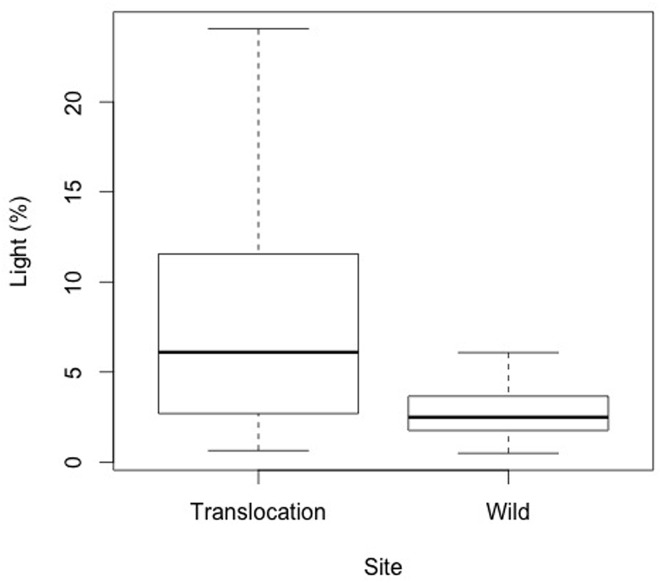
Total transmitted light in the experimental translocation site and the wild Wollemia nobilis site.